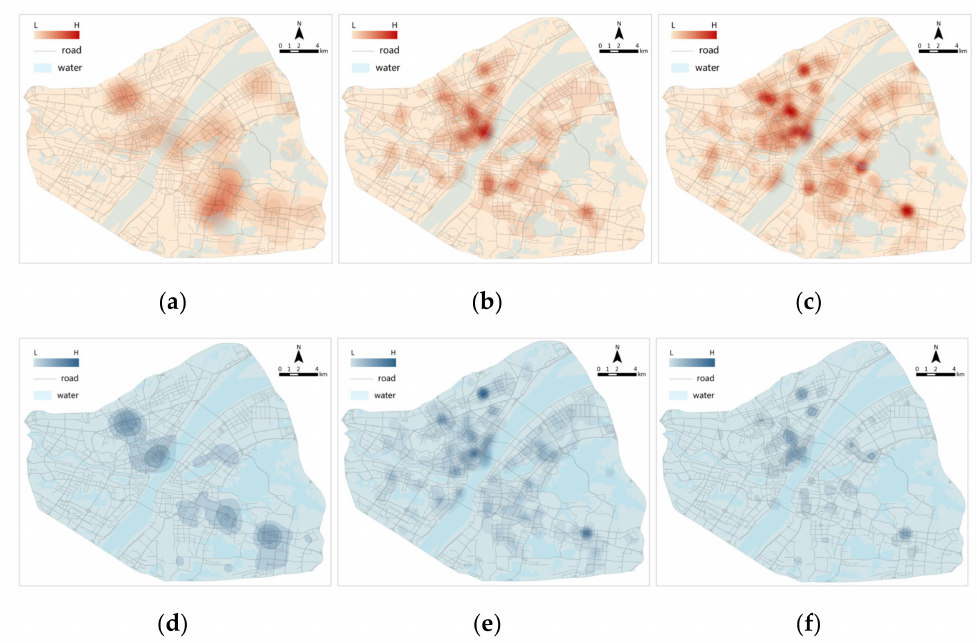
Figure 7. Kernel density distribution of emotional points: ( a ) positive emotional points in Stage A; ( b ) positive emotional points in Stage B; ( c ) positive emotional points in Stage C; ( d ) negative emotional points in Stage A; ( e ) negative emotional points in Stage B; ( f ) negative emotional points in Stage C.